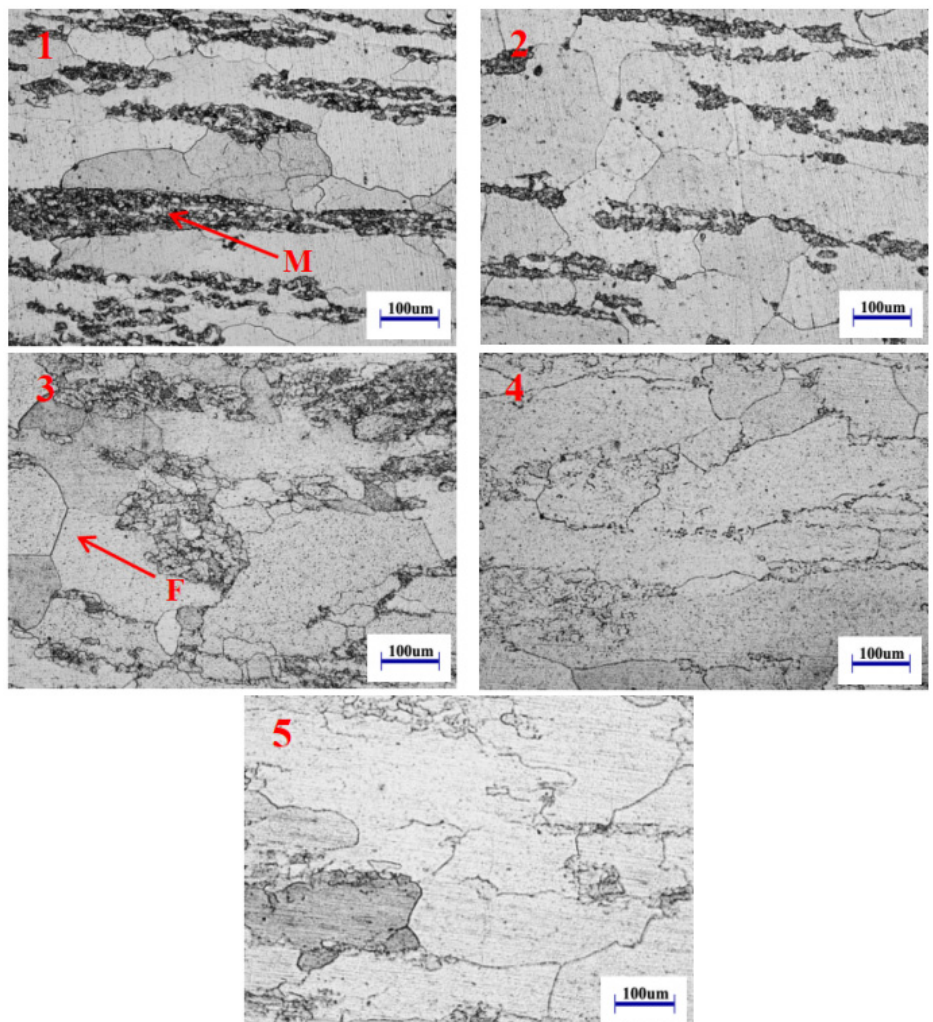
Figure 12. Microstructure of base metal at different heat treatment temperatures: ( 1 ) as-welded, ( 2 ) 720 °C, ( 3 ) 770 °C, ( 4 ) 820 °C, ( 5 ) 870 °C .